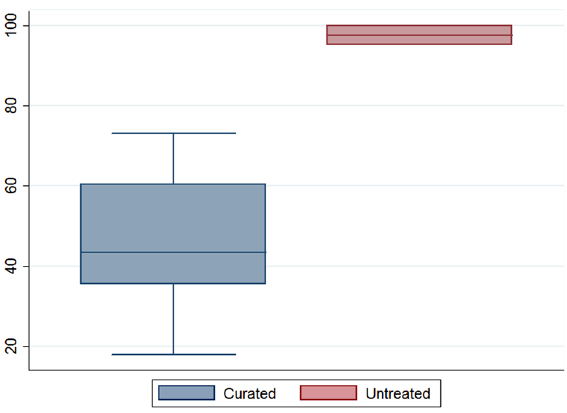
Figure 5. Box plot comparing the number of detected features between curated and untreated vessels.